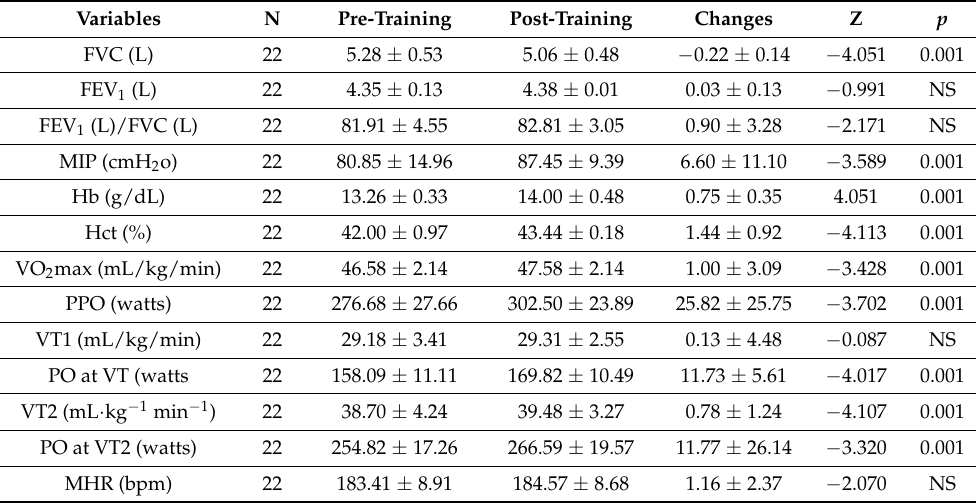
Table 2. Pulmonary function, hematological variables, and cardiorespiratory fitness biomarkers: a comparison of the pre- and post-test changes in the control